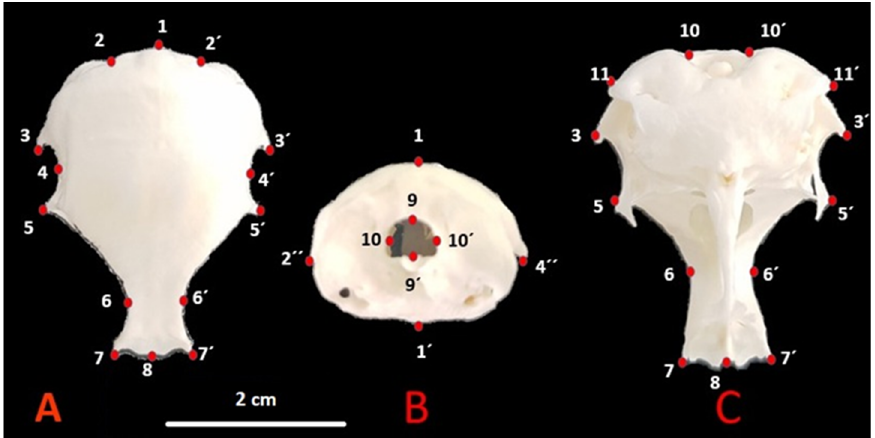
Figure 1. Skull landmarks in quail. ( A ) Dorsal, ( B ) caudal, ( C ) ventral.